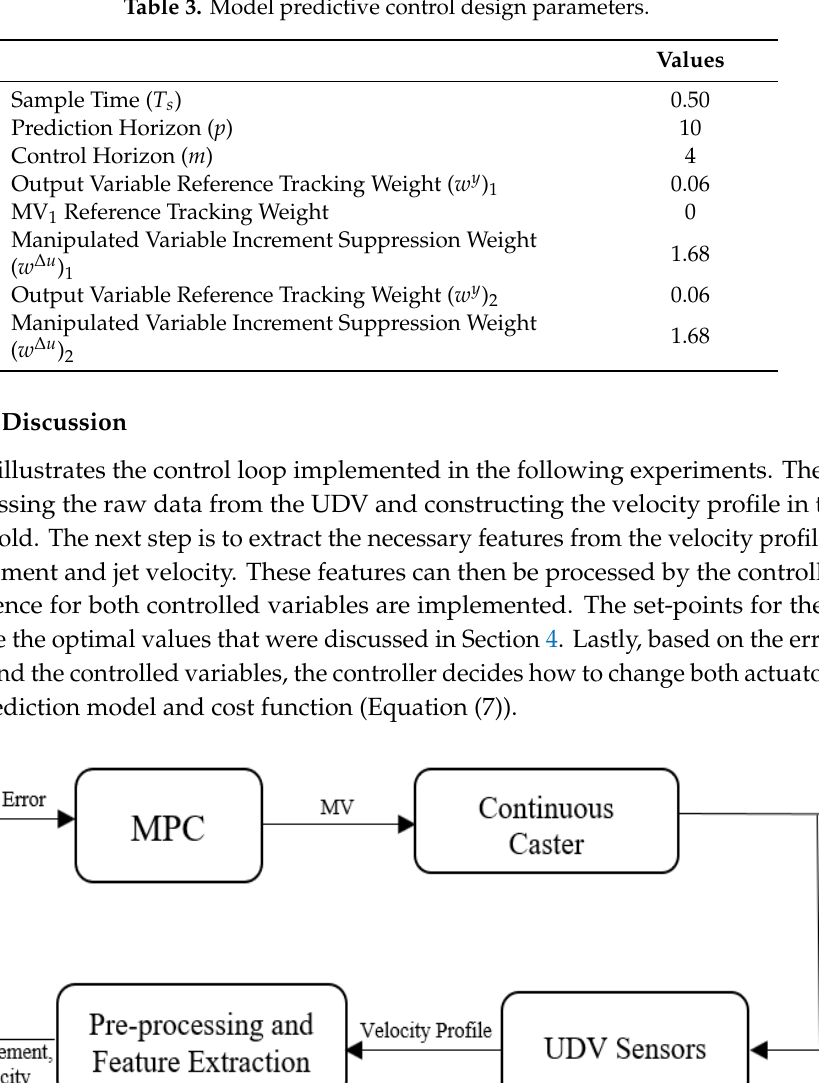
Figure 14. Closed loop response of jet impingement for set-point tracking.